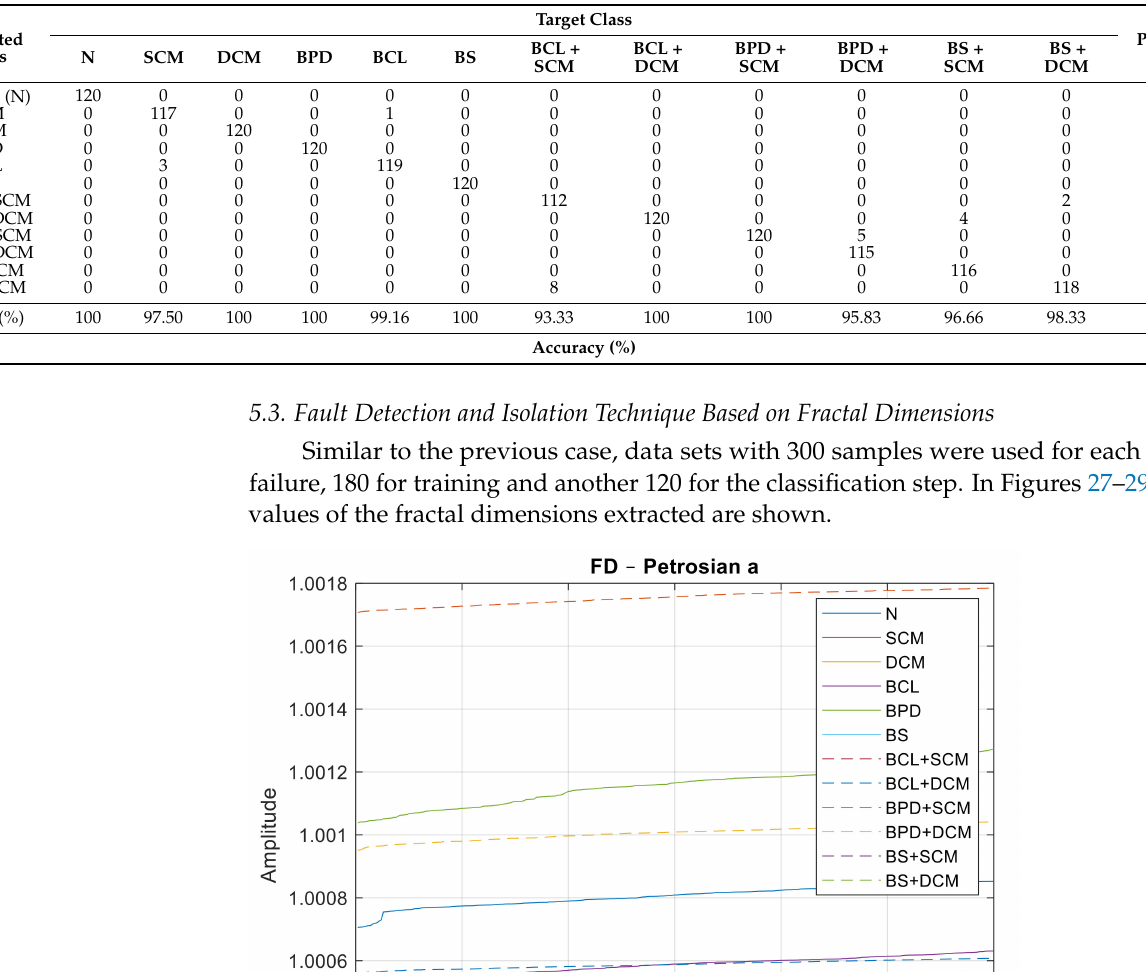
Table 5. Confusion Matrix—wavelet MRA.